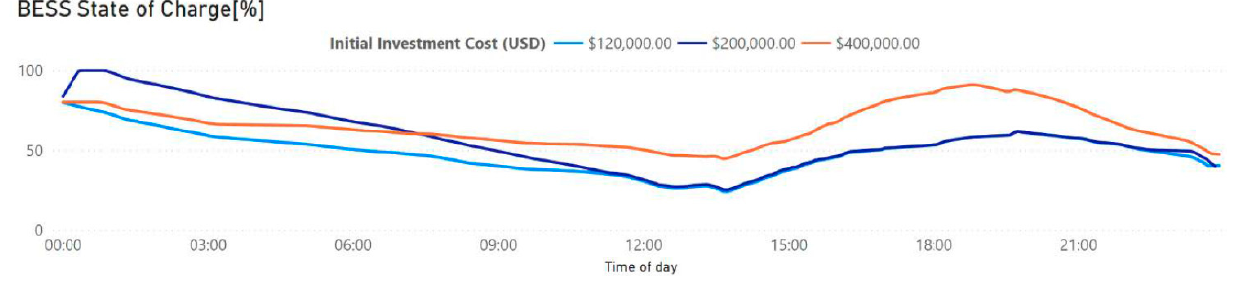
Figure 14. SOC variation by time of day for each initial investment cost.